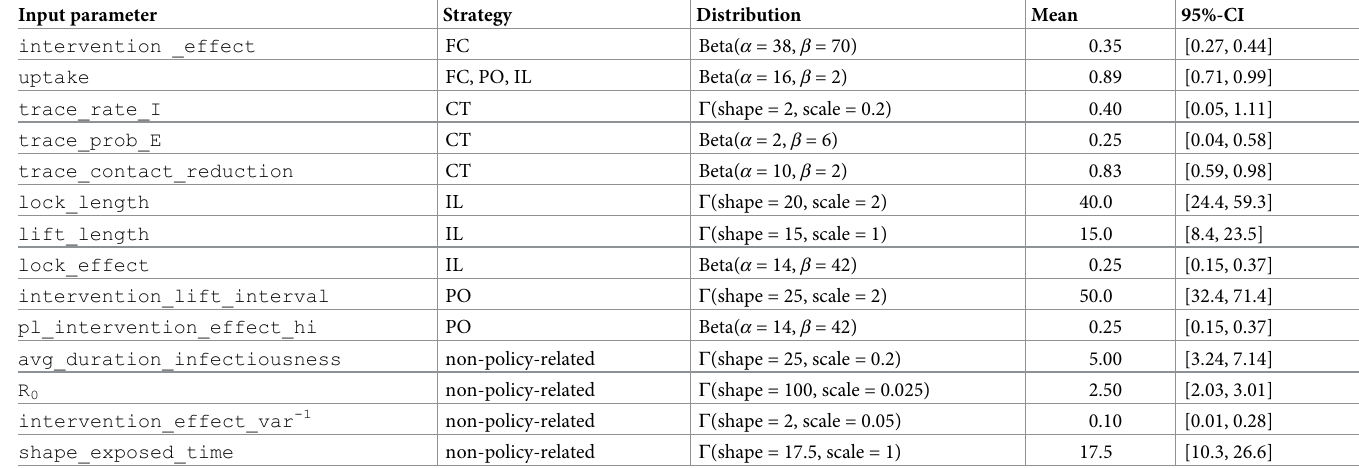
Table 1. Model parameters varied in the UQ analysis. Values represent the mean and 95%-confidence interval (95%-CI) of the input